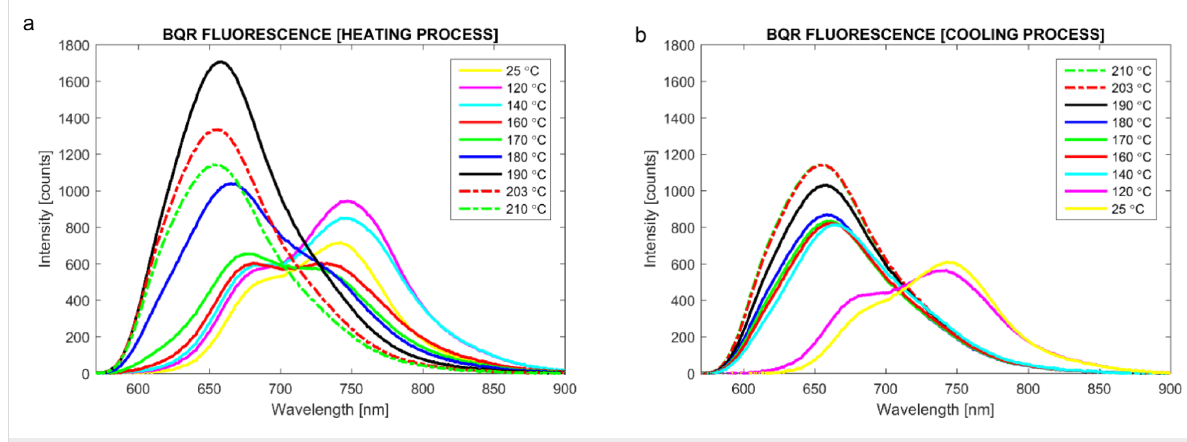
Figure 9: Variable temperature thin-film fluorescence emission profiles for BQR , a) heating and b) cooling, collected using the same apparatus as Figure 8 but with an Hg lamp as the excitation source.